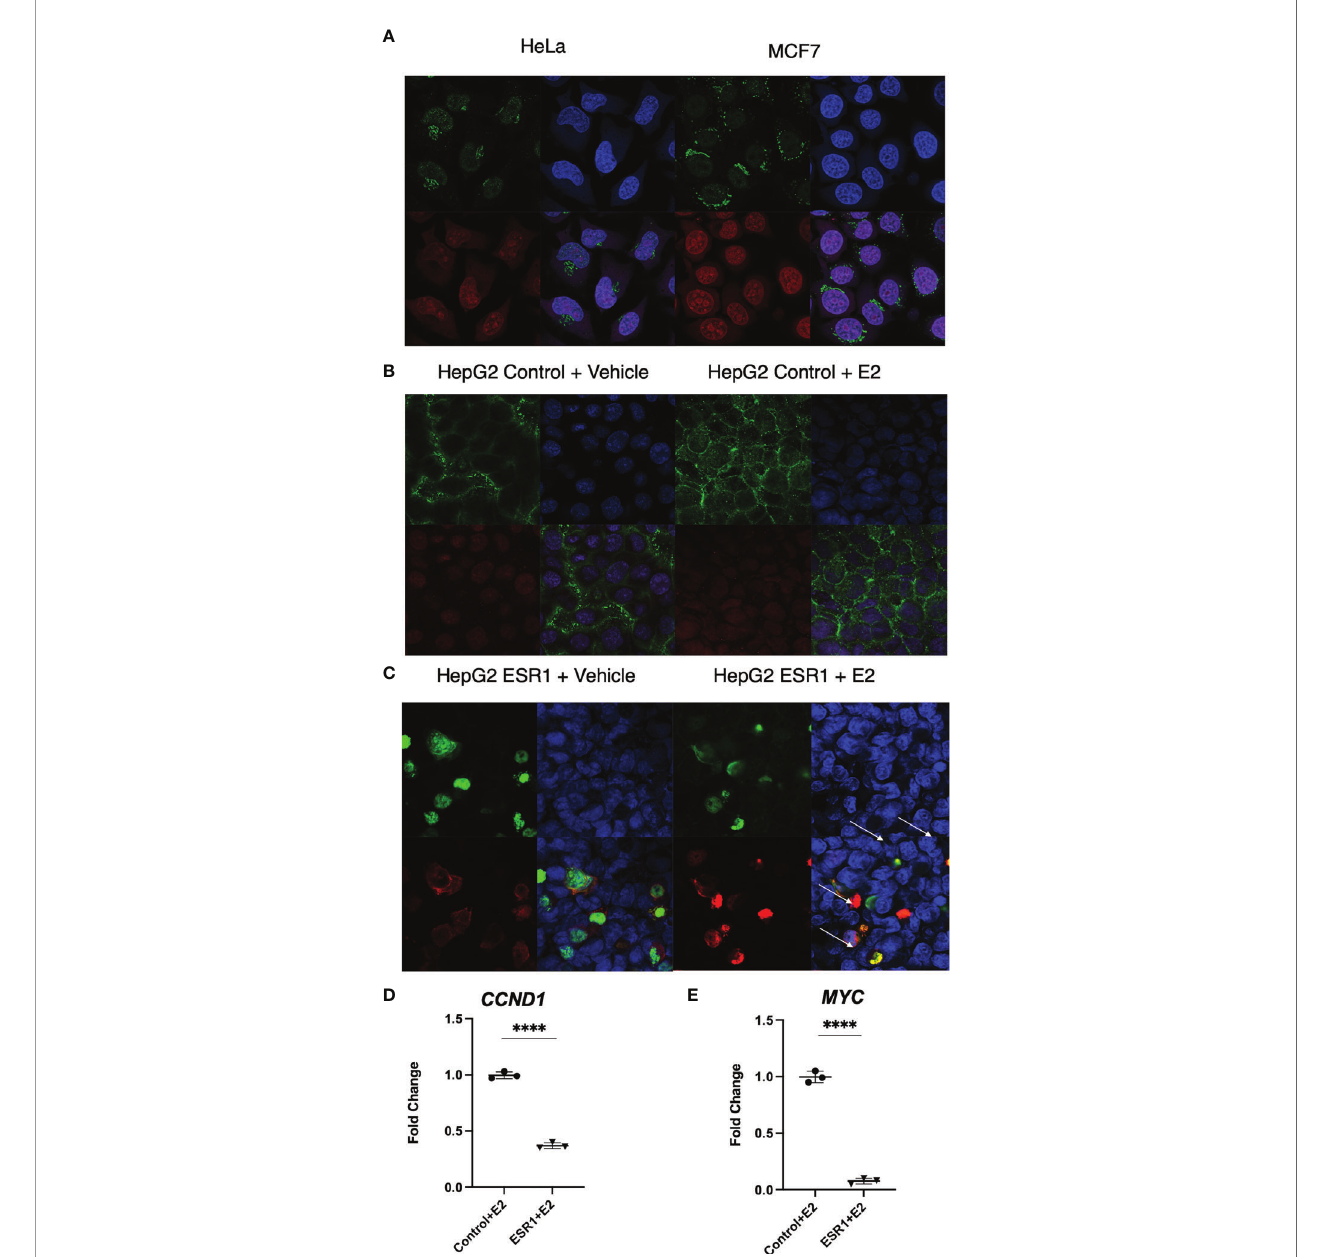
FIGURE 3 | ER- a colocalization with b -catenin decreases b -catenin target gene expression in vitro. (A) Immuno fl uorescent analysis of b -catenin (top left panel) and ER-a (bottom left panel) on HeLa and MCF7 cells. Nuclei (top right panel) were stained with DAPI. Merged image (bottom right panel) showing a nuclear localization of ER-a in MCF7 and cytoplasmic localization of b -catenin in both cell lines. The images were captured at 40X magni fi cation. (B) Immuno fl uorescent analysis of b - catenin (top left panel) and ER- a (bottom left panel) on HepG2 cells transfected with the control vector and exposed to vehicle or E2. Nuclei (top right panel) were stained with DAPI. Merged image (bottom right panel) showing the detection of cytoplasmic localization of b -catenin and absence of ER- a in the nucleus of HepG2 cells. (C) Immuno fl uorescent analysis of b -catenin (top left panel) and ER- a (bottom left panel) on HepG2 cells transfected with ESR1 coding vector and exposed to vehicle or E2. Nuclei (top right panel) were stained with DAPI. Merged image (bottom right panel) showing the concomitant detection in the nucleus of both b -catenin and ER- a in HepG2 cells represented by the yellow fl uorescence as indicated by the white arrows. The images were captured at 40X magni fi cation. (D) HepG2 cells overexpressing ESR1 expressed less CCND1 (FC = 0.3), MYC (FC = 0.065). Mean with SD values from N = 3 independent experiments are represented in the graph. ****p < 0.0001, Student ’ s t-test. SD, standard